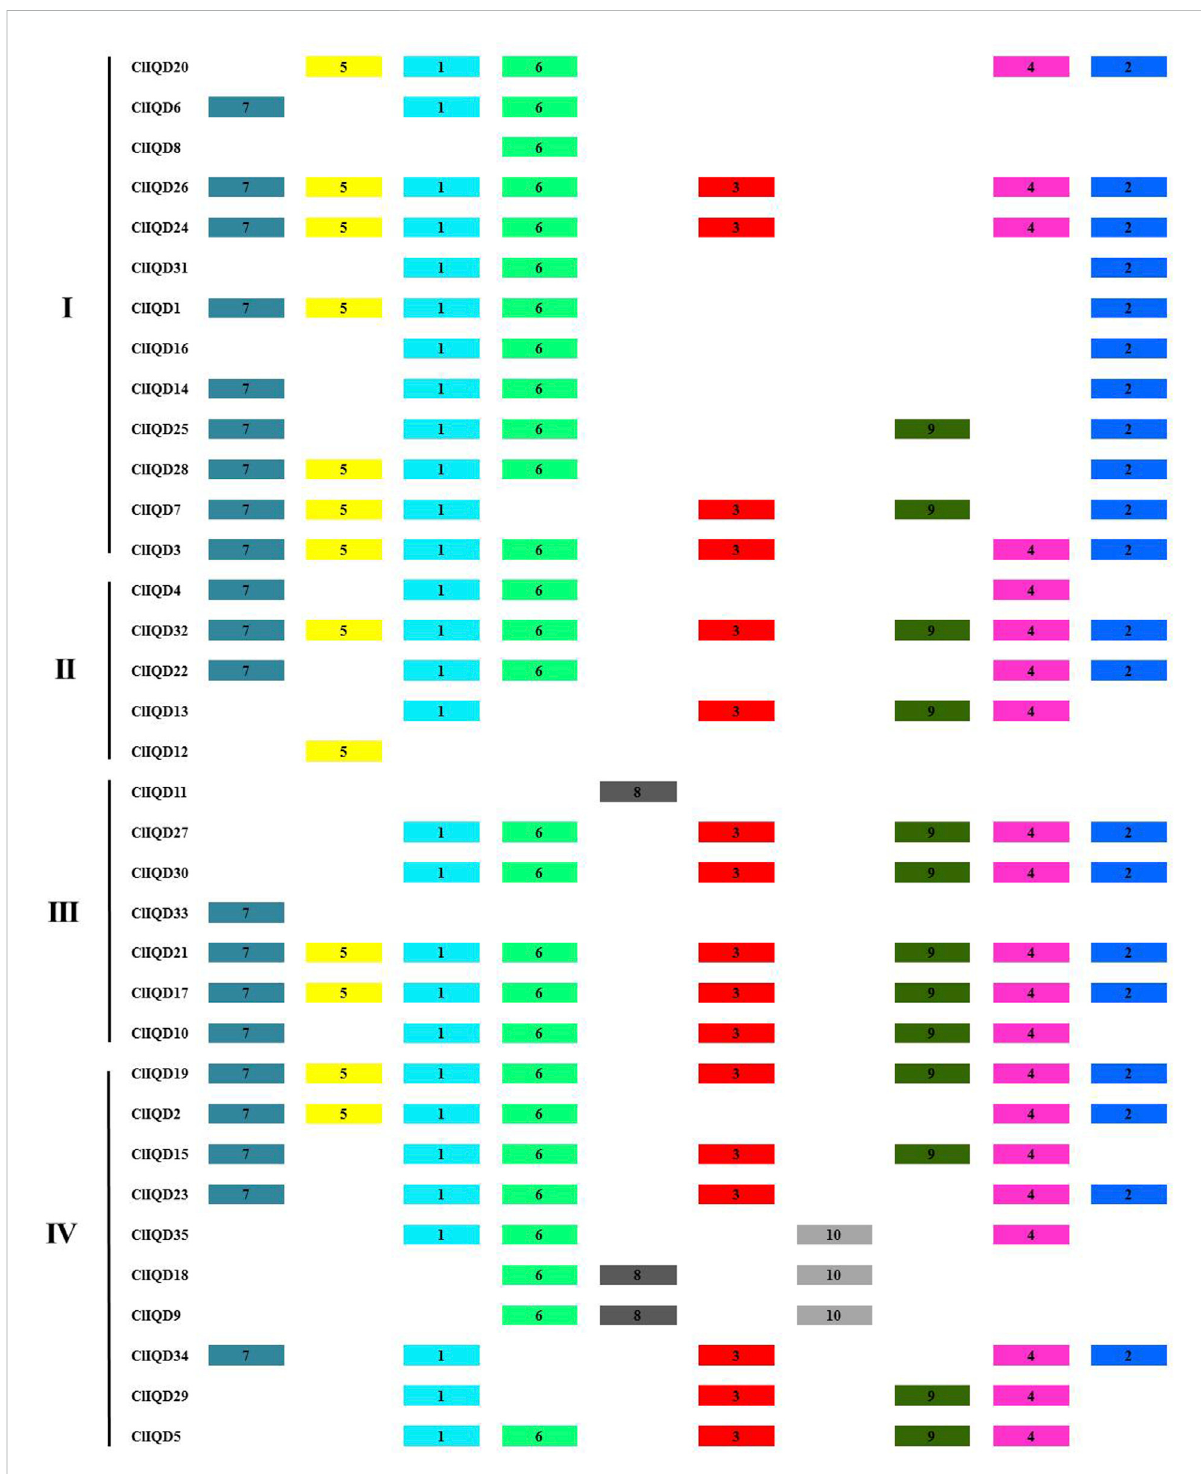
Motifpatternsofthe10conservedmotifsinClIQDproteins.Eachmotifisrepresentedbydifferentcoloredboxeswiththeserialnumberlocated in the center of the box. The colored boxes were ordered manually based on the MEME server results. The length of each colored box does not represent the virtual motif size of the corresponding